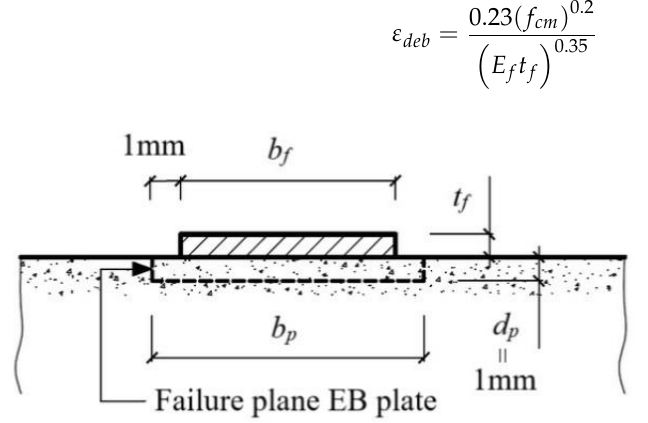
Figure 3. Idealized failure plane [18].